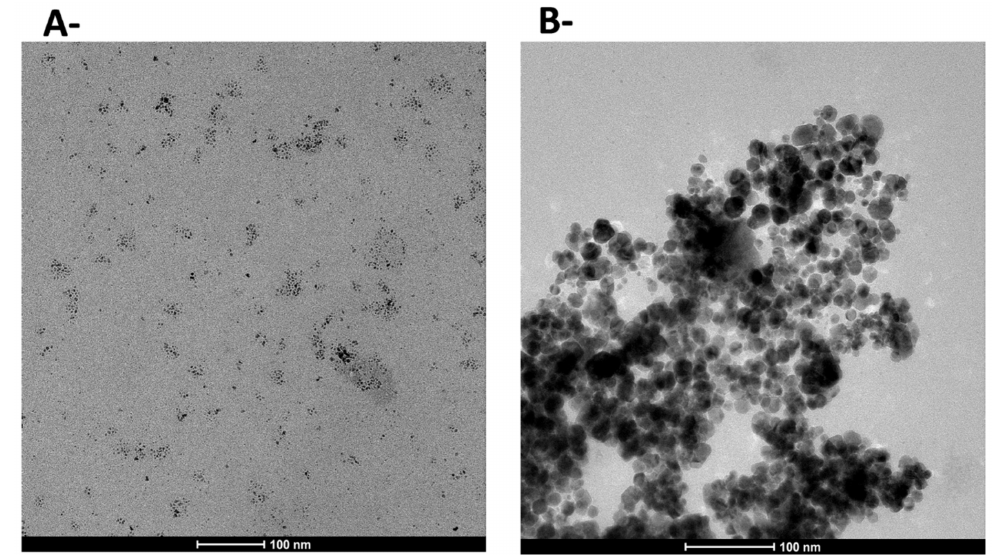
Figure 8. TEM micrographs of ( A ) fresh i-PdCl 2 (TPPTS) 2 and ( B ) i-PdCl 2 (TPPTS) 2 after the